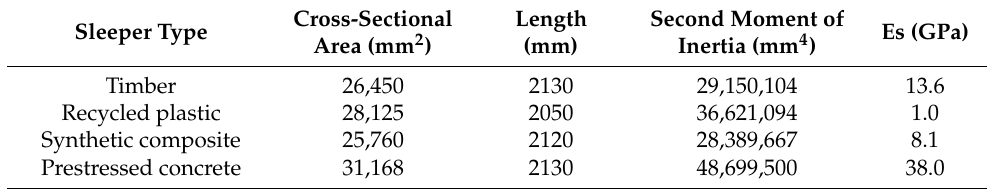
Table 3. Properties of the sleeper